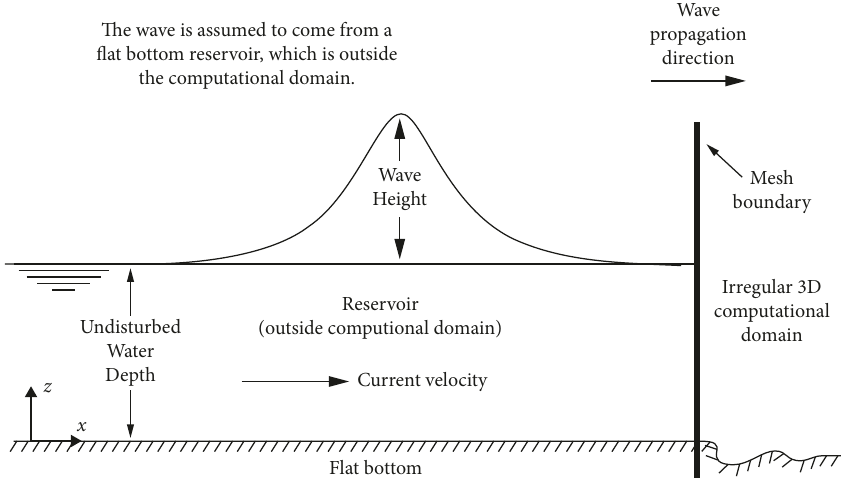
Figure 4: Inputs required for solitary wave generation: wave height, mean water depth, and current